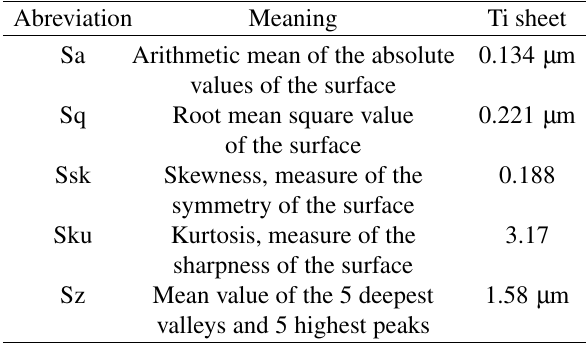
Table 1 . Some three-dimension parameters used to describe sur- faces. The example is referred to the titanium sheet presented in Fig. 3.